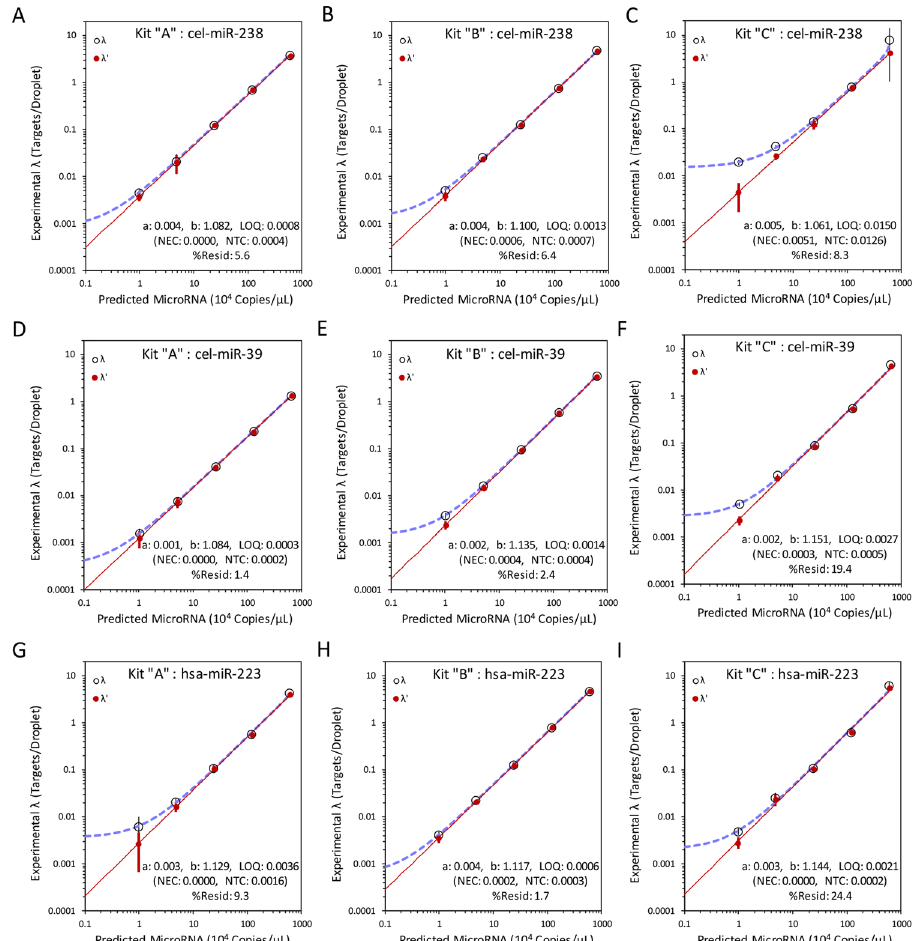
Fig 6. Model for miRNA quantification using synthetic oligonucleotides. miRNA titrations were performed with (A, D, G) cDNA Kit “A”, (B, E, H) cDNA Kit “B”, and (C, F, I) cDNA Kit “C”. The cDNA synthesis kits and targets were measuredwith droplet digital PCR system. Average no template control (NTC) and no enzyme control (NEC) were similarlymeasuredfor each experiment. Fraction positive targets per droplet were calculatedeither without subtracting averageNEC and NTC positives( λ ; open circles, purpleline) or with subtractingNEC and NTC positive ( λ ’; closed red circles, red line) droplets. For each kit and each target (A to C) cel-miR-238, (D to F) cel-miR-39, and (G to I) hsa-miR-223, both λ (dashedpurpleline) or λ ’ (solid red line) were graphedon a single x -axis versus estimated 10 4 miRNA copies/ μ Lmaster mix. A simple power curve, y = a x b , was calculatedfor normalizeddata, λ ’. Limit of quantification (LOQ) was predictedbasedon the lowest possiblevalue that satisfied the power curve. Individual data points are shown with corresponding standarduncertainties. Microsoft Excel was used to calculateand graph